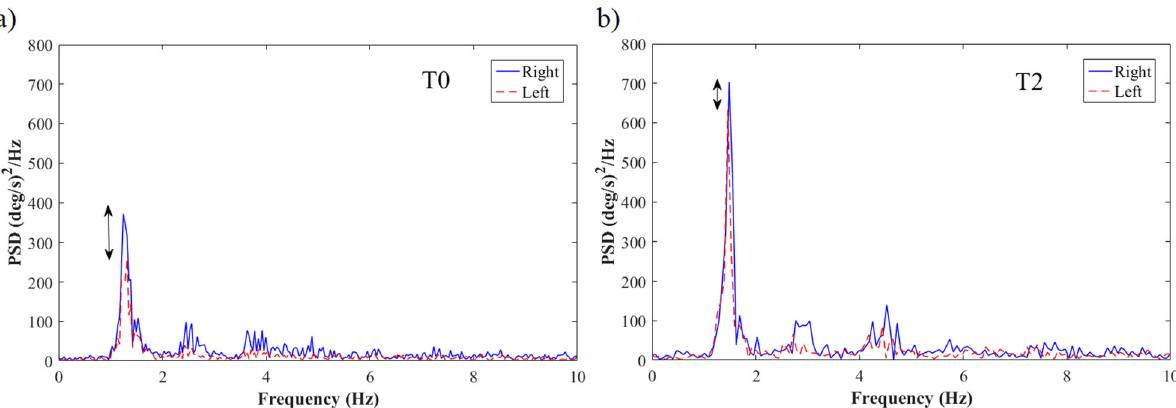
Fig. 1 Evolution of RAHM amplitude after dopaminergic therapy initiation. The graphs show the power spectral density of the angular velocity measured by the sensor placed on right and left hand of a PD patient at T0 ( a ) and T2 ( b ). At the baseline ( a ), it is evident a reduced maximum value of the power spectral density and an asymmetry between right and left limb (measured by the feature Power and Asym_Power, respectively), which both improved with the therapy ( b